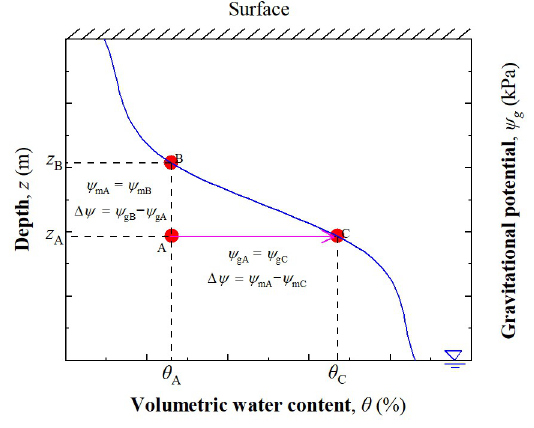
Figure 2. Schematic diagram of soil water characteristic curve. Table 1. List of main symbols.